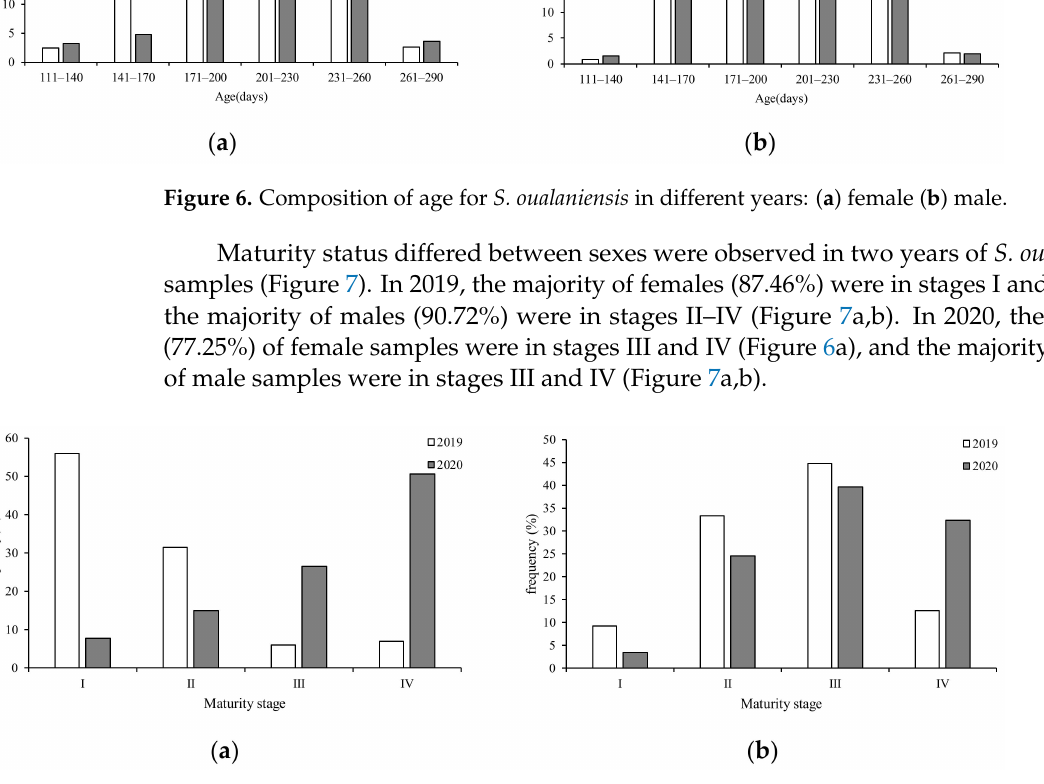
Figure 7. Maturity stage compositions of the two S. oualaniensis sexes in the northwest Indian Ocean in the two years of study: ( a ) female; ( b )